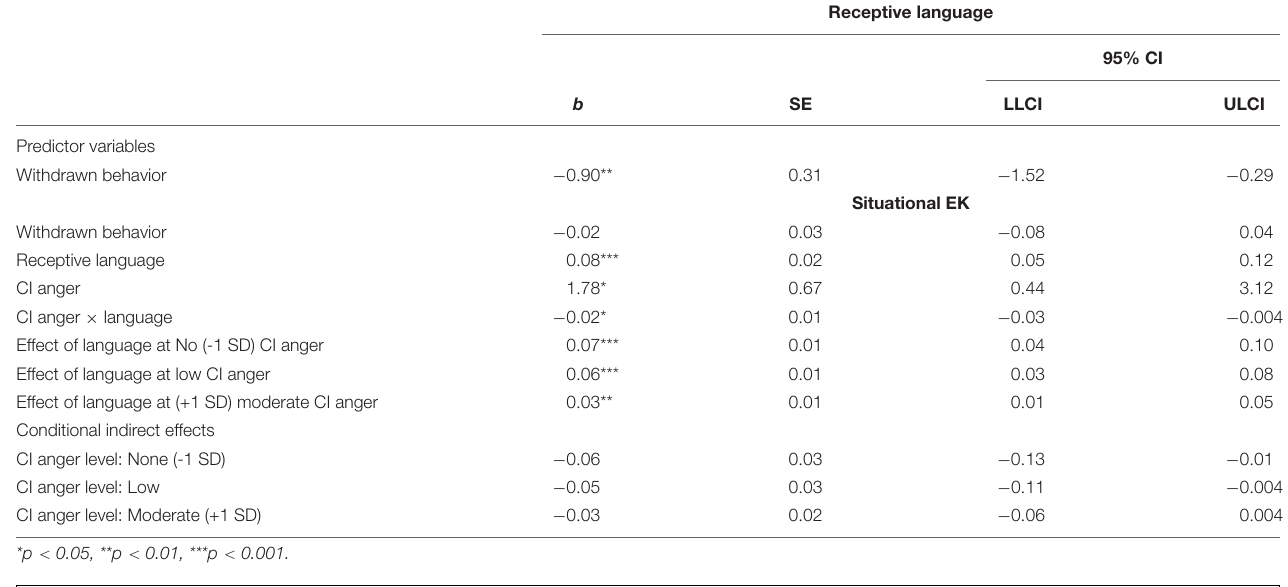
TABLE 4 | CI anger moderation of language mediation effect on situational EK in withdrawn children.